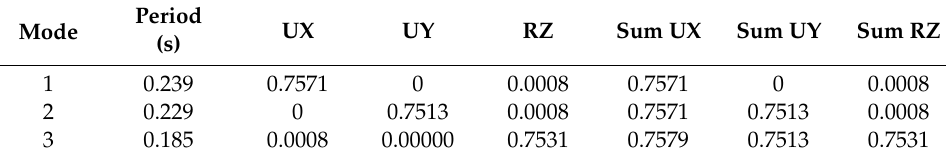
Table 14. Ratios of the modal participating mass after the reducing of the